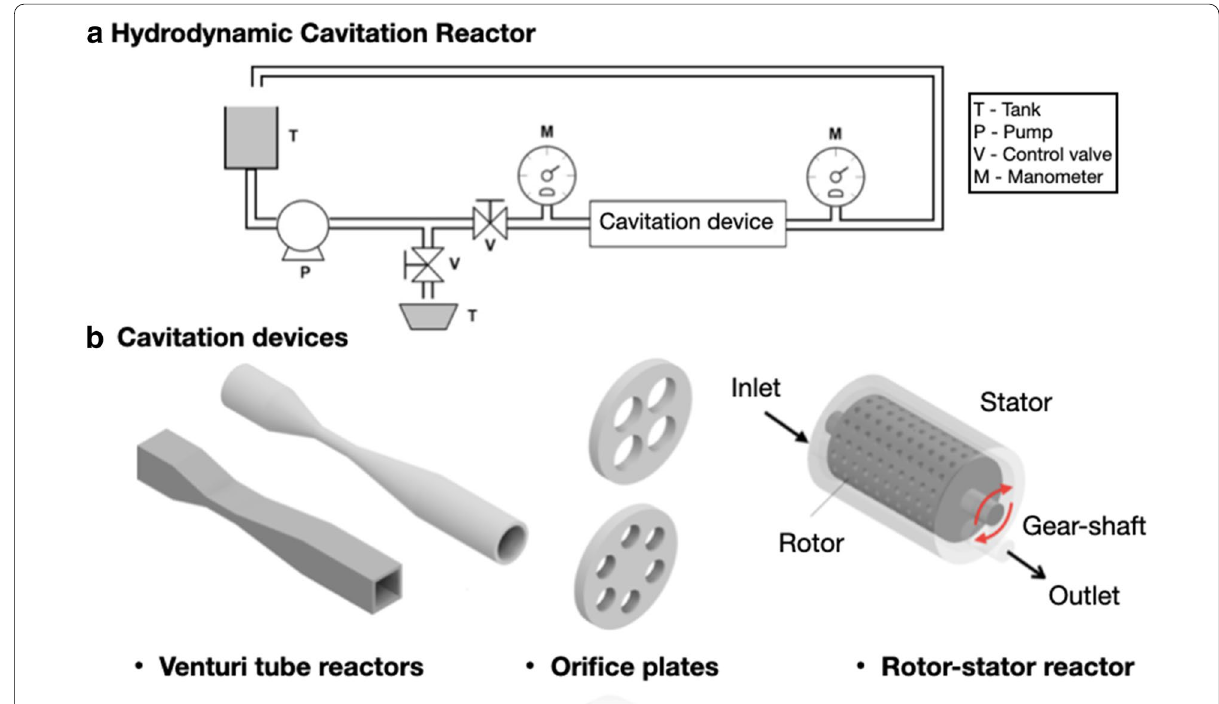
Fig. 1 Schematic diagram of different HC